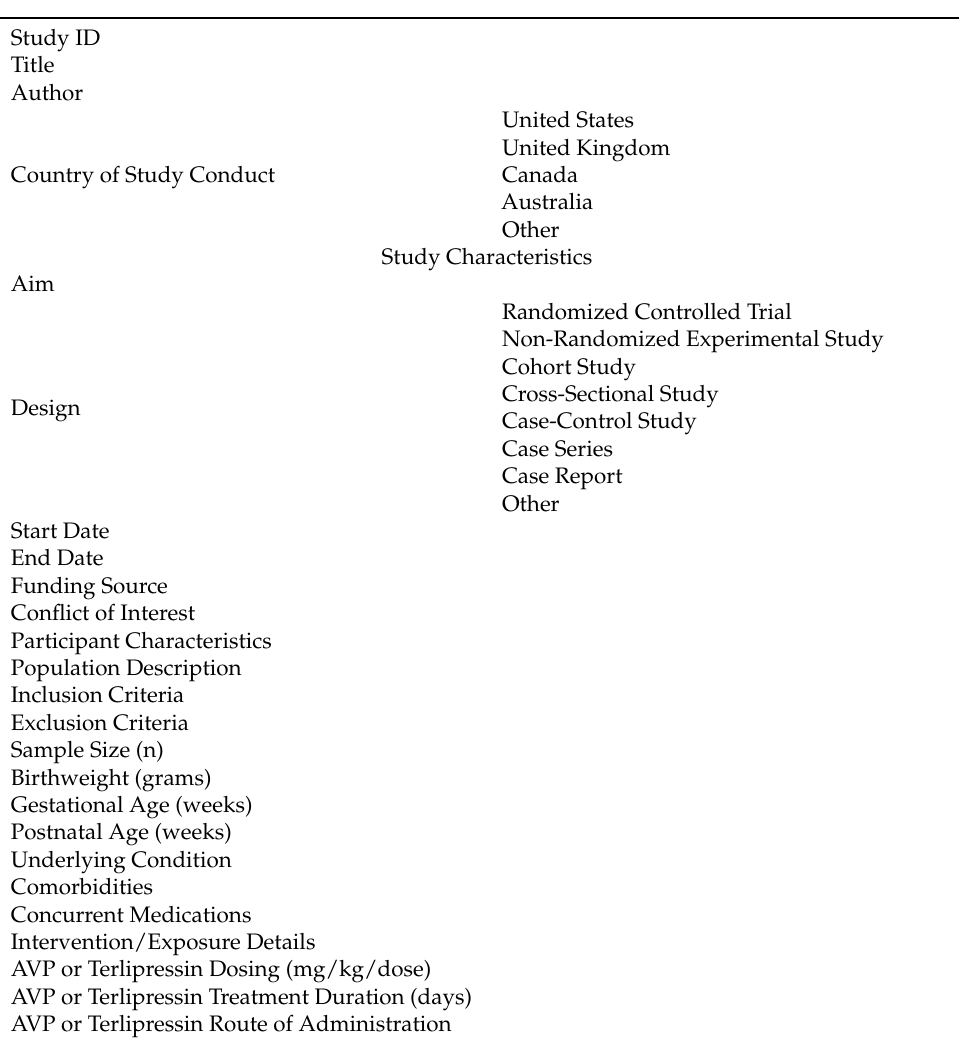
Table A2. Data Extraction for Primary